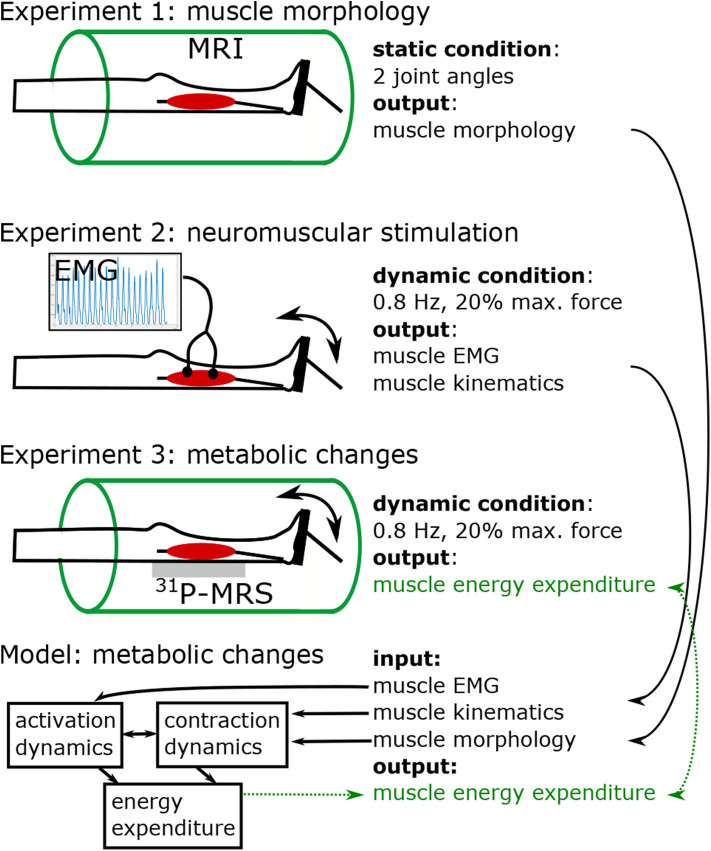
Study design, including three experiments and model based simulation of energy turnover changes in loaded calf muscle. Experiment 1: Structural MRI to determine muscle volume, muscle-tendon-unit length, fiber length, fiber angle, and lever arm in two joint angles (neutral, and extended). Morphological data was used to individualize the leg-foot geometry in the muscle model. Experiments 2 (EMG) and 3 (31P-MRS) were performed in a contracting calf muscle at 20% of the single repetition maximum force with 0.8 Hz pedaling cadence. Data from Experiment 2 were used to determine dynamic muscle length (based on recorded joint angle) and myoelectrical stimulations (EMG) during the exercise. The 31P-MRS data were used to quantify the ATP turnover and to determine the muscular energy expenditure, which was compared with the output of model based simulations. The model receives input from experiment 1 in terms of muscle parameters and experiment 2 in terms of dynamic muscle length and EMG.